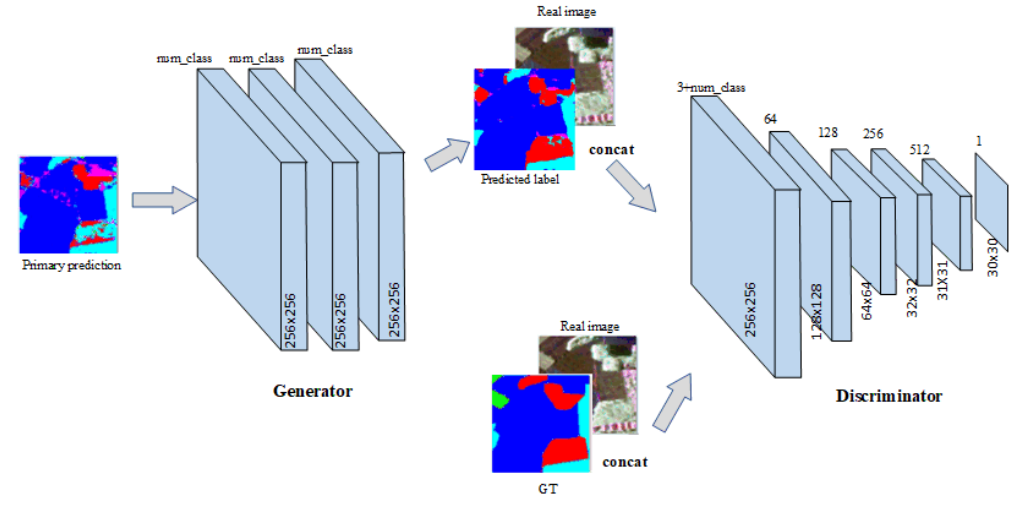
Figure 4. Structure of the likelihood network-GAN. The generator uses a three-layer convolution, which acts as a learning spatial filter. The discrimination using six-layer convolution is the same as